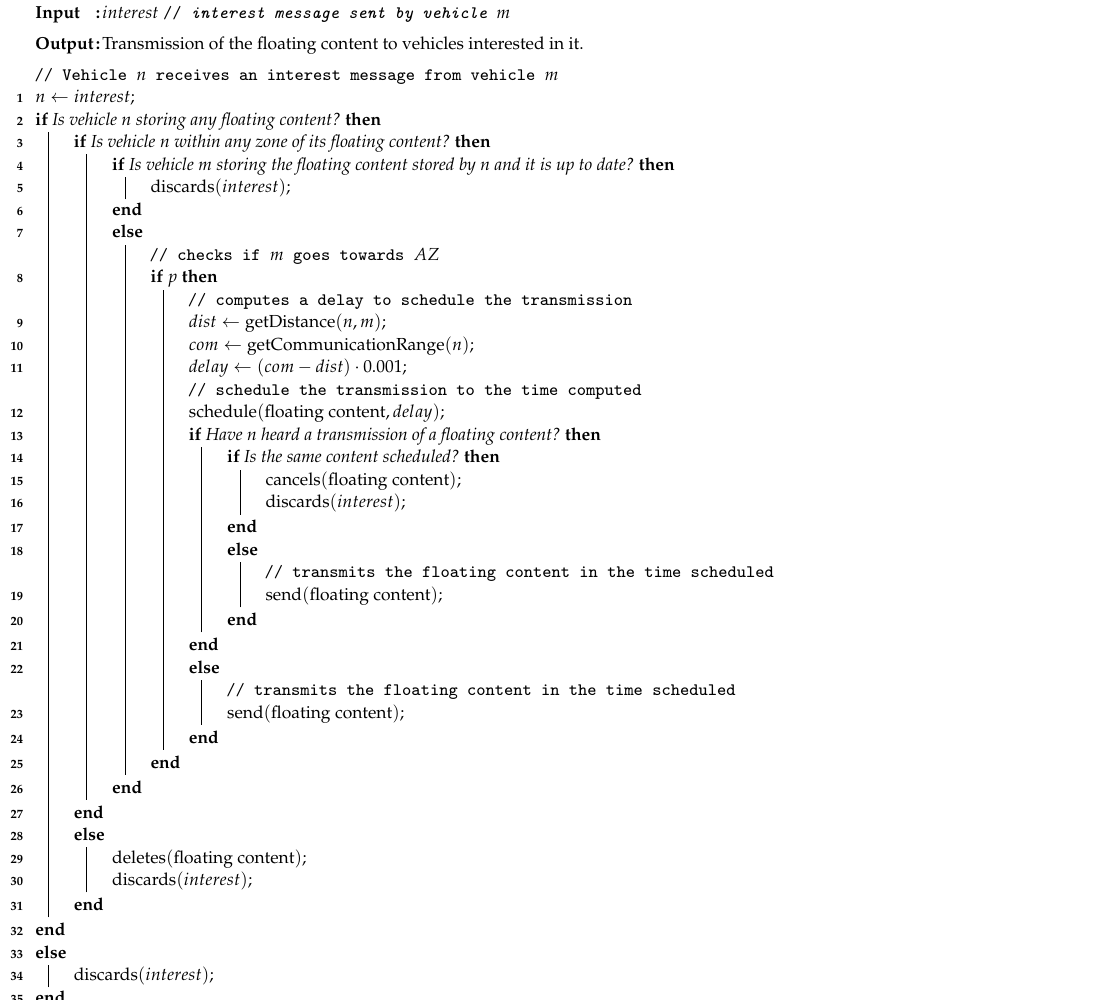
Algorithm 2: Opportunistic content sharing procedure to ensure the availability and survivability of a floating